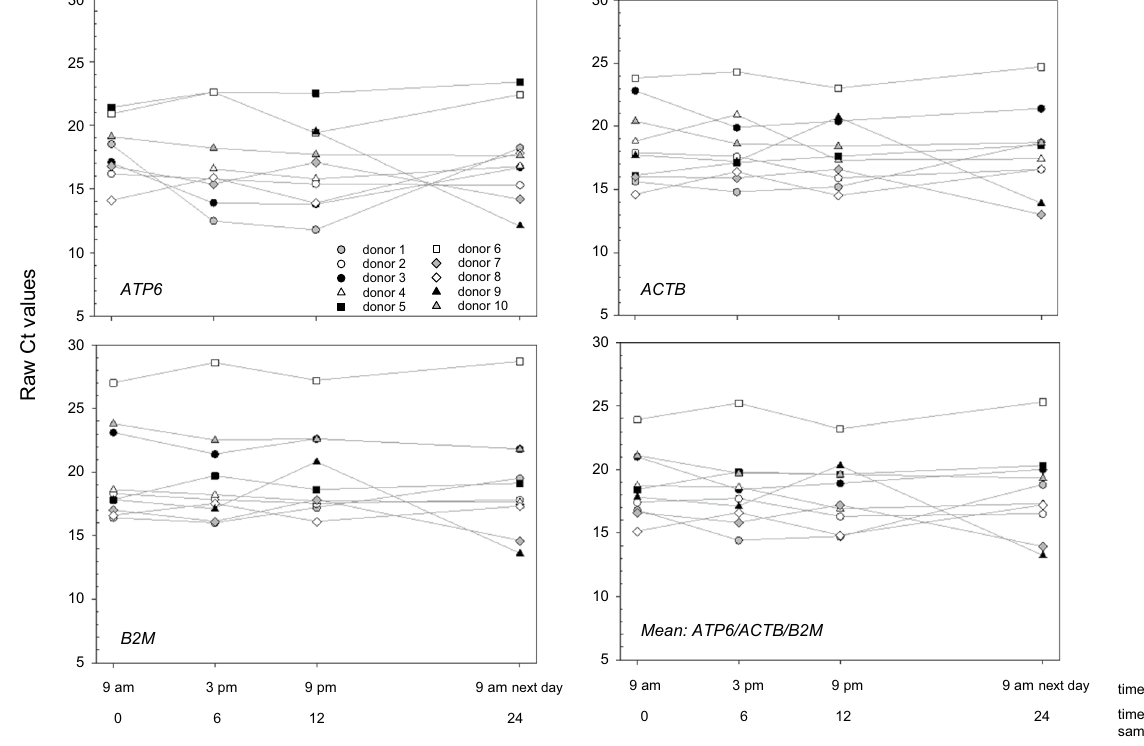
Figure 6. Raw Ct values (threshold cycles) of three candidate house-keeping genes ( ACTB , ATP6 and B2M ) as well as a combination of them (arithmetic mean) are depicted over time (four time point each: 9 am—0